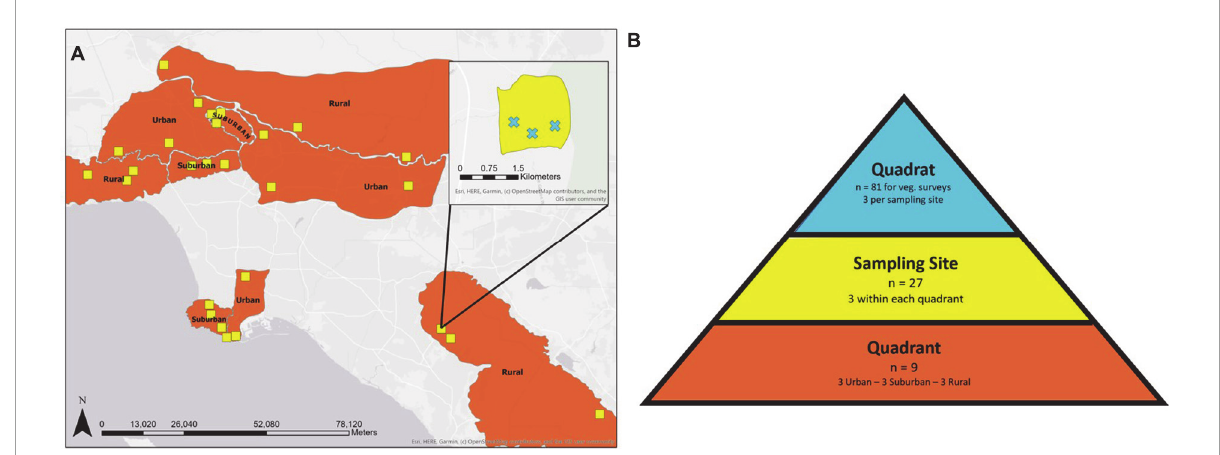
FIGURE1 (A) Map of sampling sites across the greater Los Angeles region. Orange polygons depict quadrants, yellow squares depict sampling sites, and blue crosses depict 1 m × 1 m quadrats (only one site shown in figure). (B) Conceptual figure of our sampling design with colors corresponding to panel (A) where orange depicts quadrants, yellow depicts sampling sites, and blue depicts